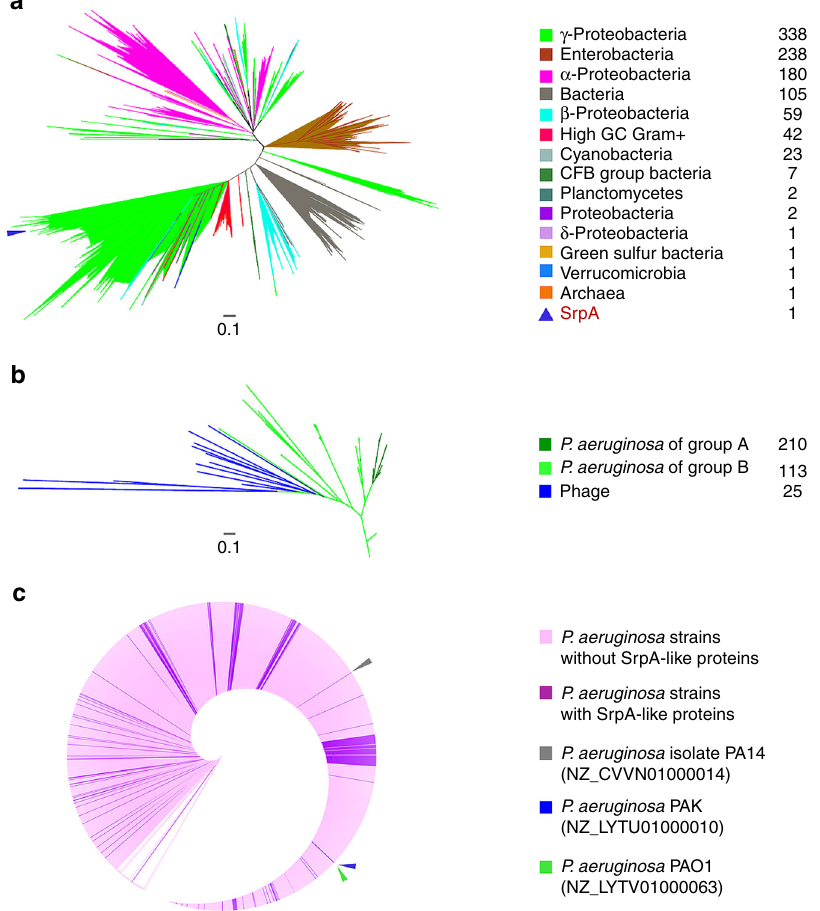
Fig. 9 Prevalence of SrpA-like proteins. a Phylogenetic tree of the SrpA-like proteins ( n = 1000) with the E -values lower than 5 E − 08. Blue triangle stands for the SrpA protein. The scale bar represents the number of substitutions per site. b Phylogenetic tree of the SrpA-like proteins of P. aeruginosa and phages. The scale bar represents the number of substitution per site. Dark green branches stand for the SrpA homologs ( n = 210) from the genome database of Pseudomonas with the E -value lower than 9.2 E − 17 (group A). Green branches stand for the SrpA homologs ( n = 113) in P. aeruginosa strains from the non-redundant protein sequences (nr) database with the E -value lower than 0.001 (group B). Blue branches stand for the SrpA homologs in phages from the non-redundant protein sequences (nr) database with the E -value lower than 0.001 ( n = 25). c Phylogenetic analysis of the 2156 P. aeruginosa strains on the basis of the 16s rRNA gene sequence. Branch lengths are ignored in the phylogenetic tree circle. Pink lines stand for P. aeruginosa strains. Purple lines stand for the strains with SrpA homologs. Colored triangles stand for the reference strains PA14, PAK, and PAO1, respectively. The colored squares represent different groups as